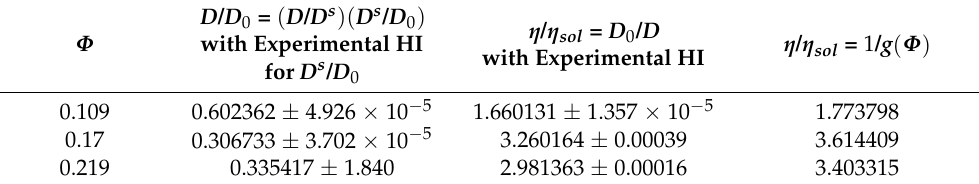
Table 2. Maghemite ferrofluid at T = 298 K , using experimental data from Meriguet, G. et al. [2] for S ( k ) and its fit with RMSA given in Figure 6. From low to high, Φ parameters in potential Equation (4) are ( γ (cid:48) , κ (cid:48) ) = ( 8.1843, 6838.3094 ) , ( 4.3263, 405.06416 ) , and ( 3.8567,252.8522 ) .